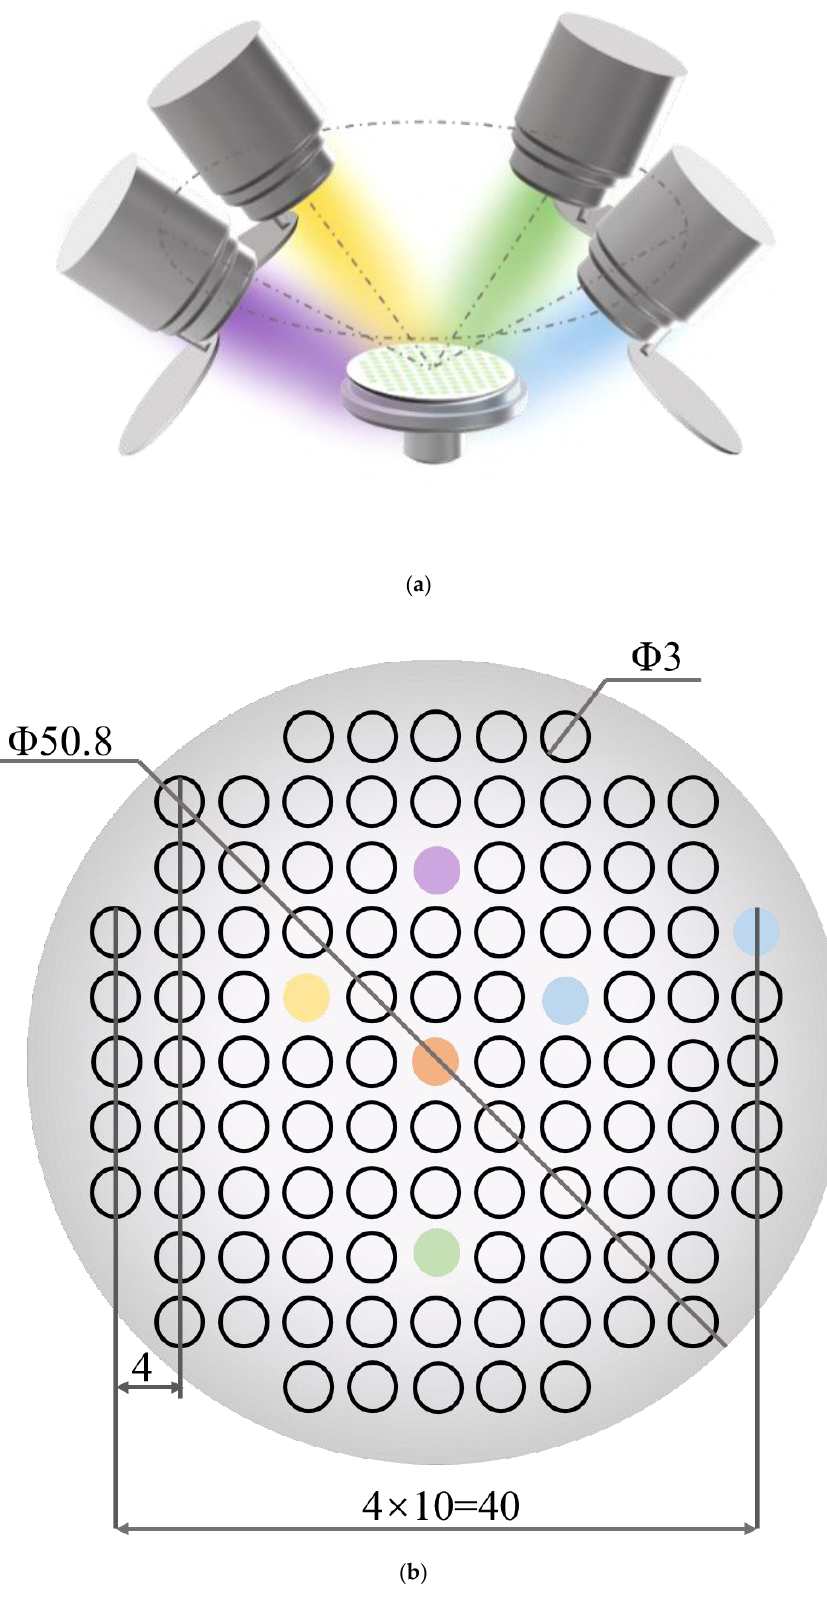
Figure 1. ( a ) Schematic diagram of the four-target co-sputtering. ( b ) The dimensional design of the aluminum mask plate.